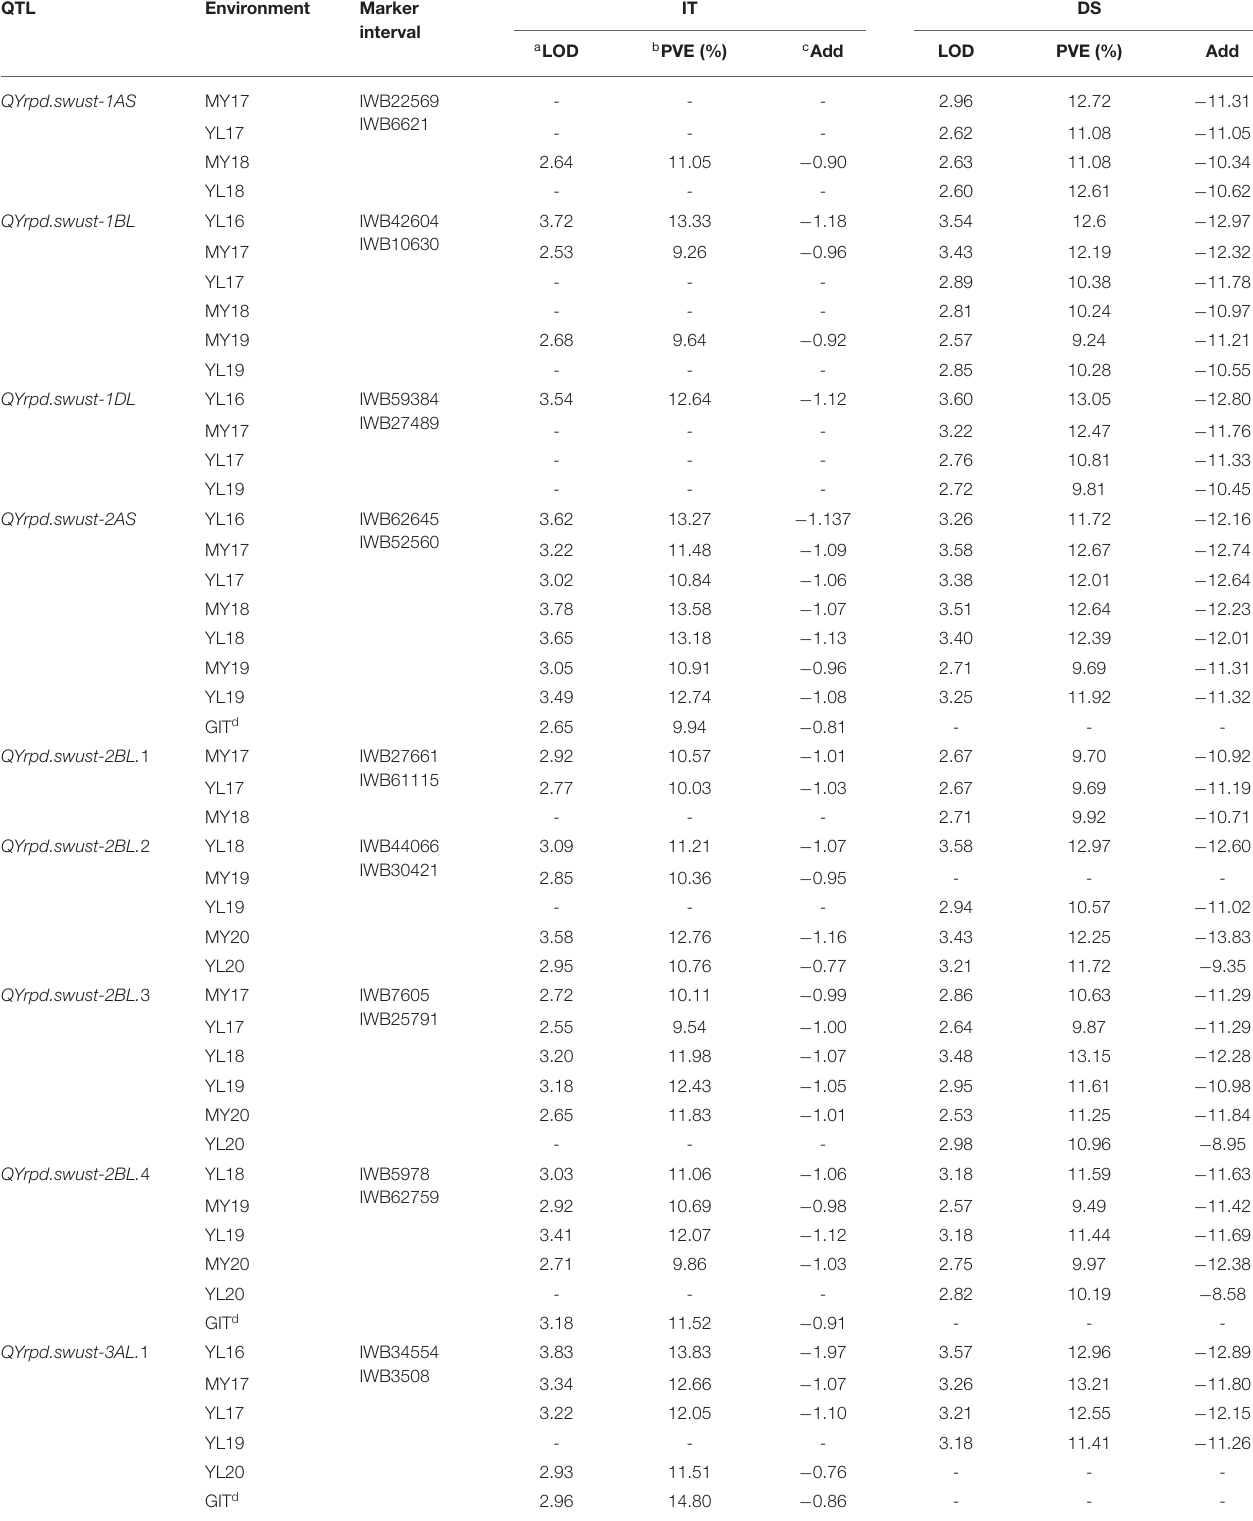
TABLE 4 | Summary of 15 stripe rust resistance QTLs identified using ICIM based on the mean disease severity (DS) and infection type (IT) of the 119 RILs from the cross of Mingxian 169 × Pindong 34 tested in Mianyang and Yangling in 2016–2020.